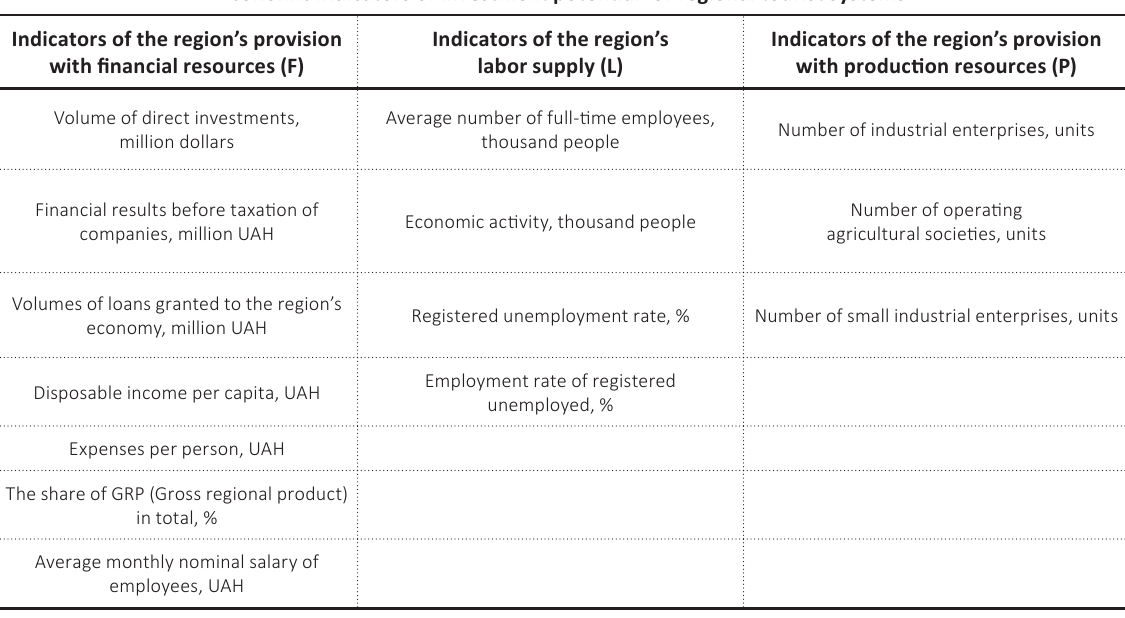
Table B1. Indicators for the analysis of investment potential for regional tourist